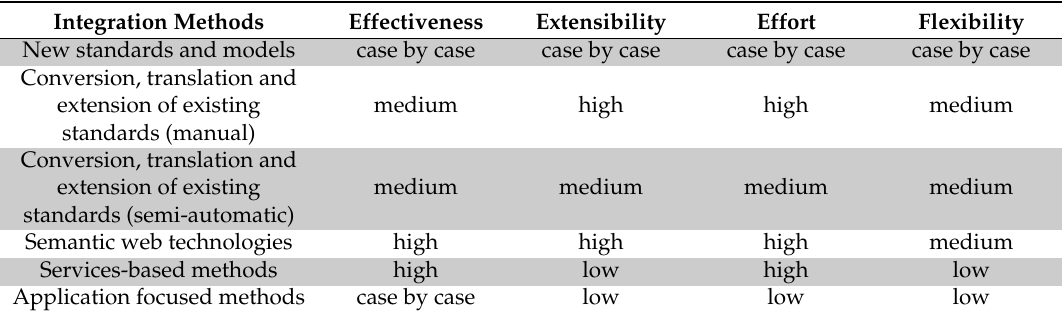
Table 1. Comparison of integration solutions by “EEEF”